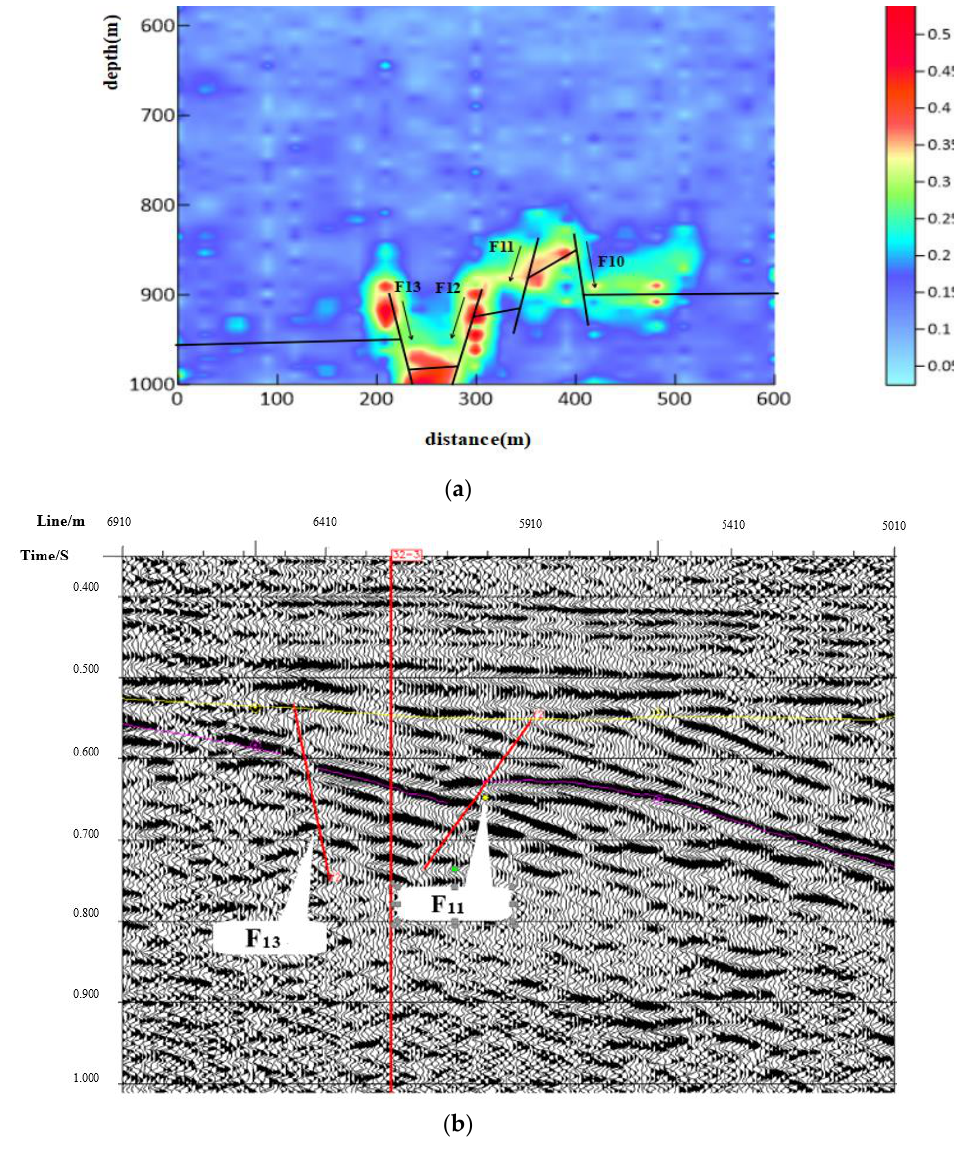
Figure 7. ( a ) The 2D semi-quantitative SLF inversion profile of the measurement sites No. 8 – No. 16; ( b ) the corresponding seismic travel time profile. ( b ) the corresponding seismic travel time